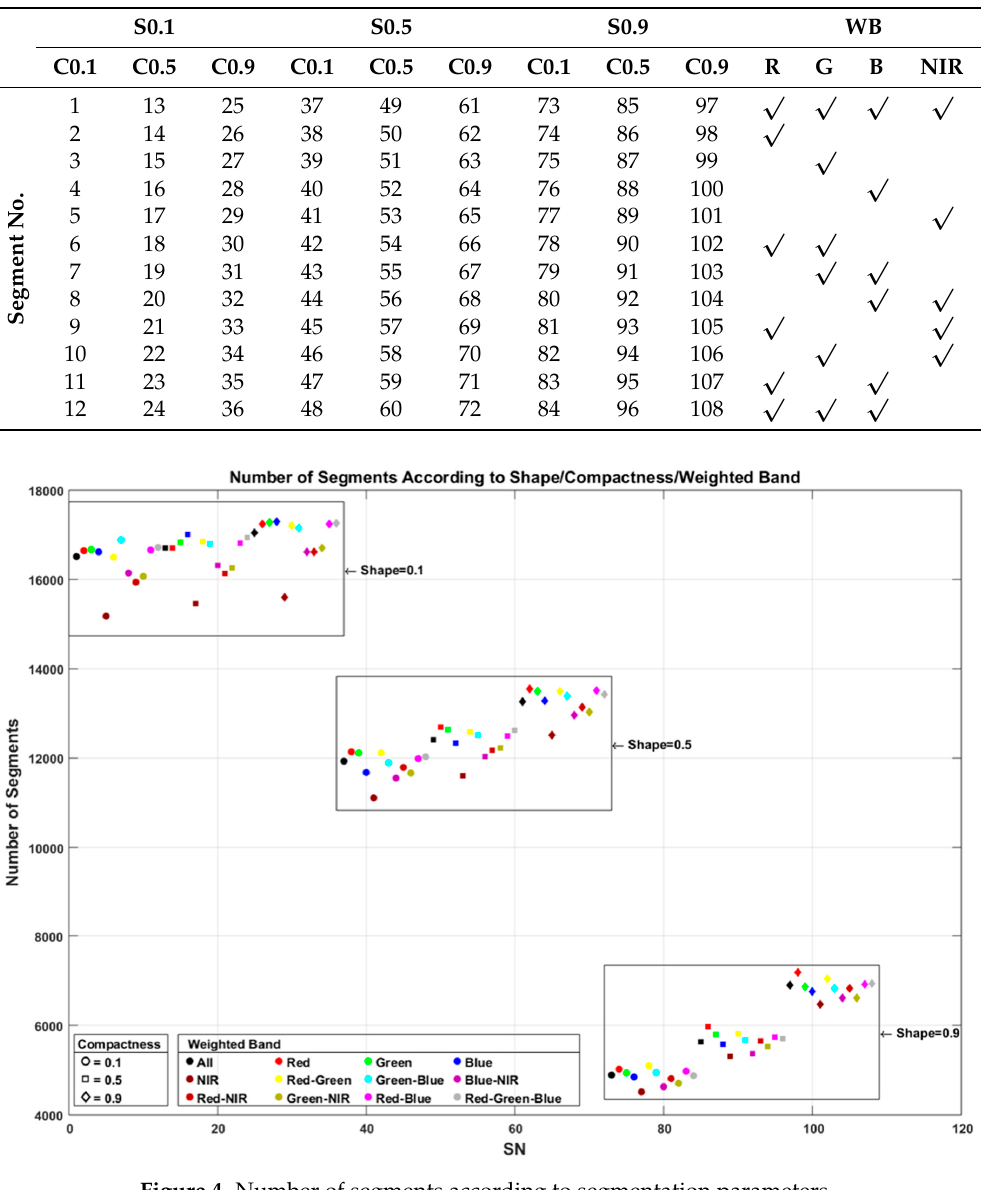
Table 3. Produced segmentations using different parameters.